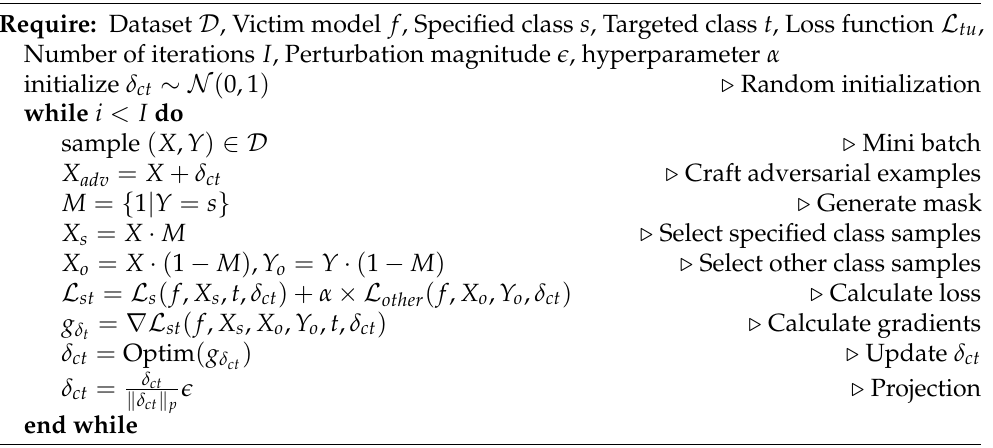
Algorithm 2 Source-targeted universal